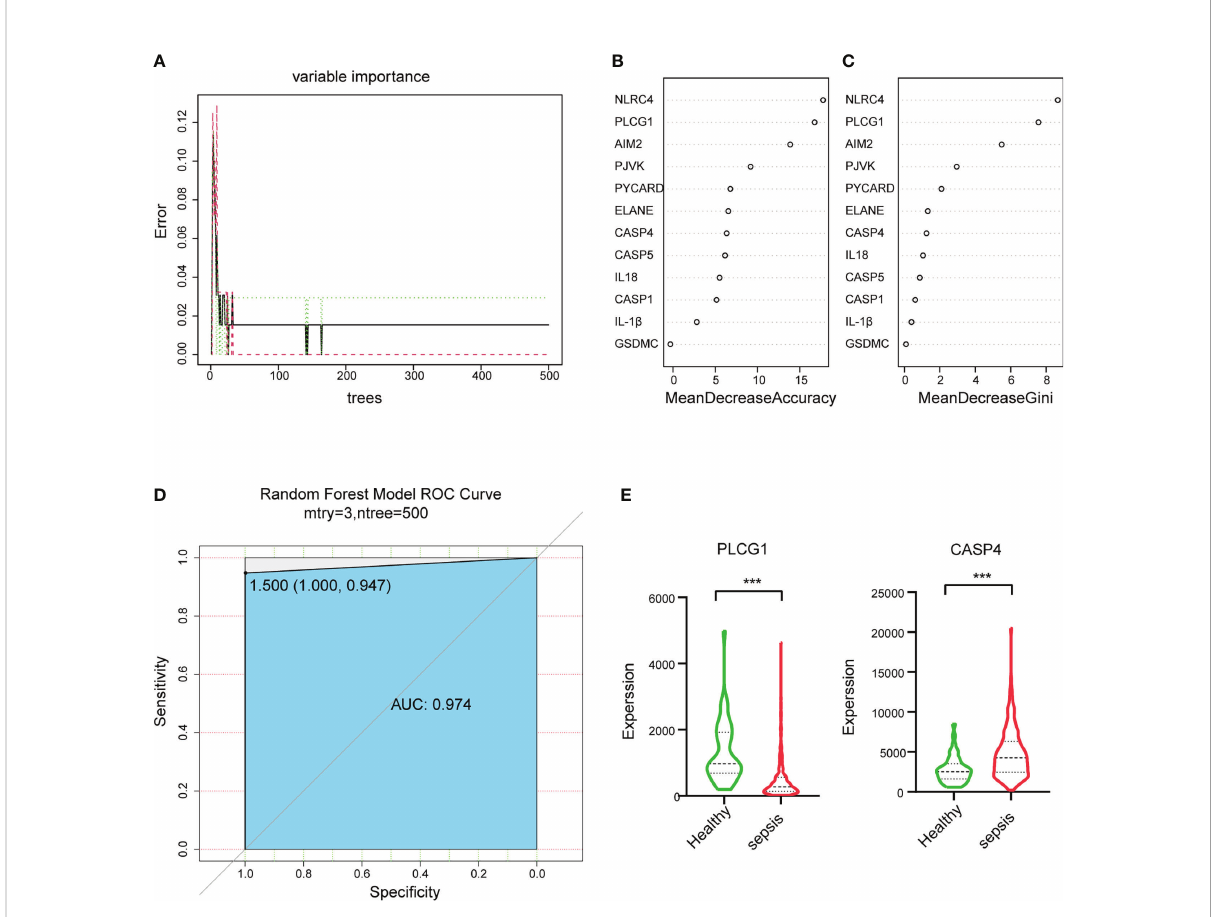
FIGURE 5 Random forest (RF) algorithm to select hub genes in GSE154918 datasets and validation of hub genes in GSE185263. (A) The impact of the number of decision trees on the error rate. (B) The importance index of genetic variables, ranked by MeanDecreaseAccuracy and (C) MeanDecreaseGini. (D) ROC curve. (E) The expression level of two biomarkers in GSE185263. ROC, receiver operating characteristic. ***P <